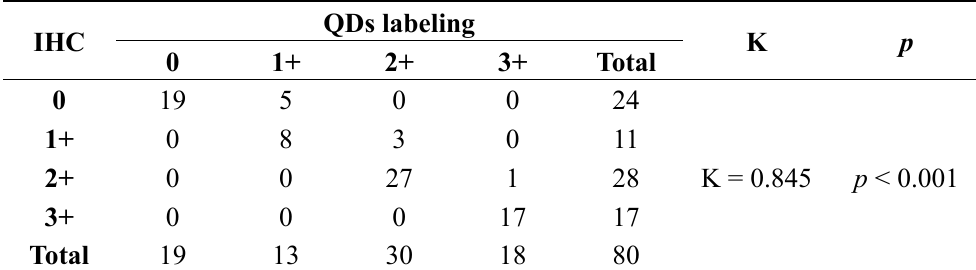
Table 3. Consistency analysis of QDs labeling and IHC technology for detecting the different levels of PSCA expression in various prostate